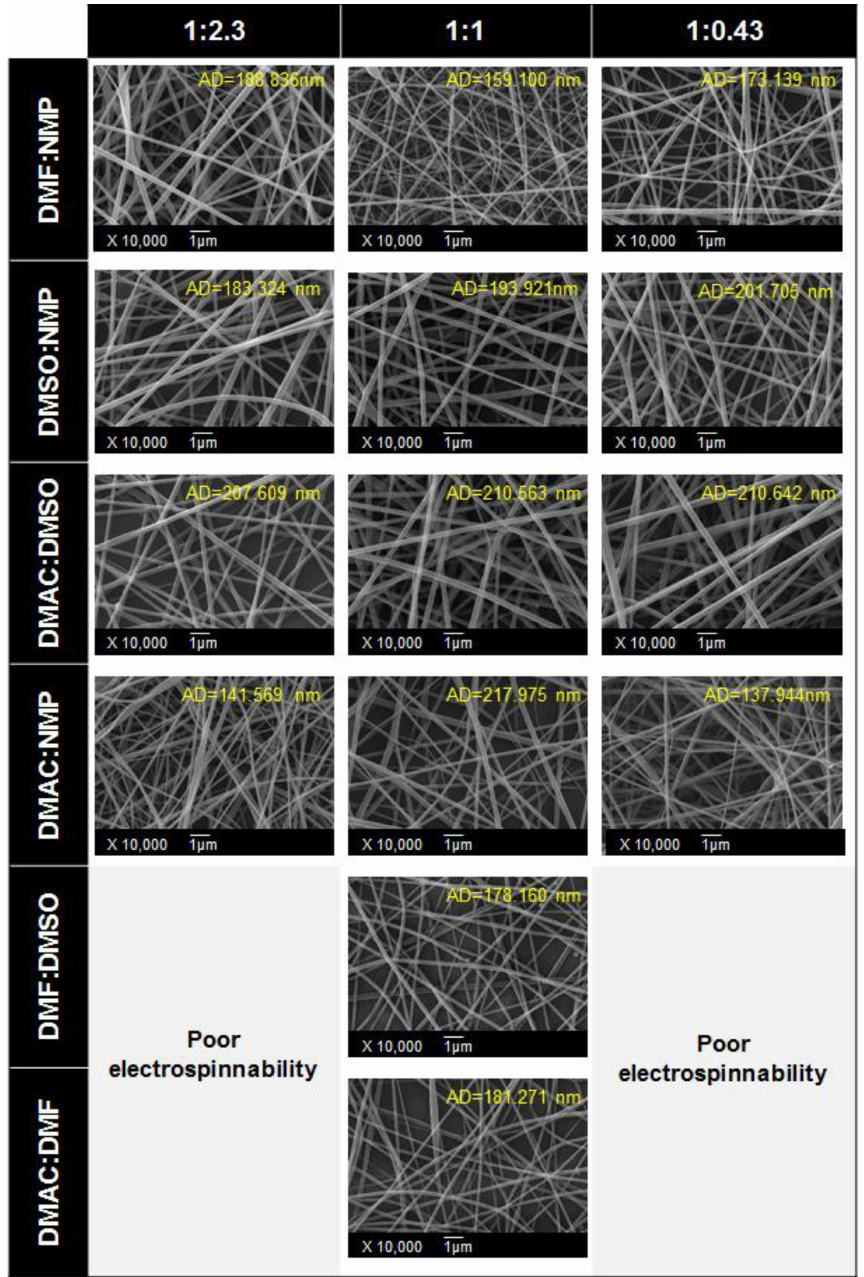
Figure 7. FESEM morphologies of electrospun 15 wt% Polyimide (PI) solutions mixed with DMF, DMSO, NMP, and DMAC in binary solvent systems. Reprinted with permission from ref.